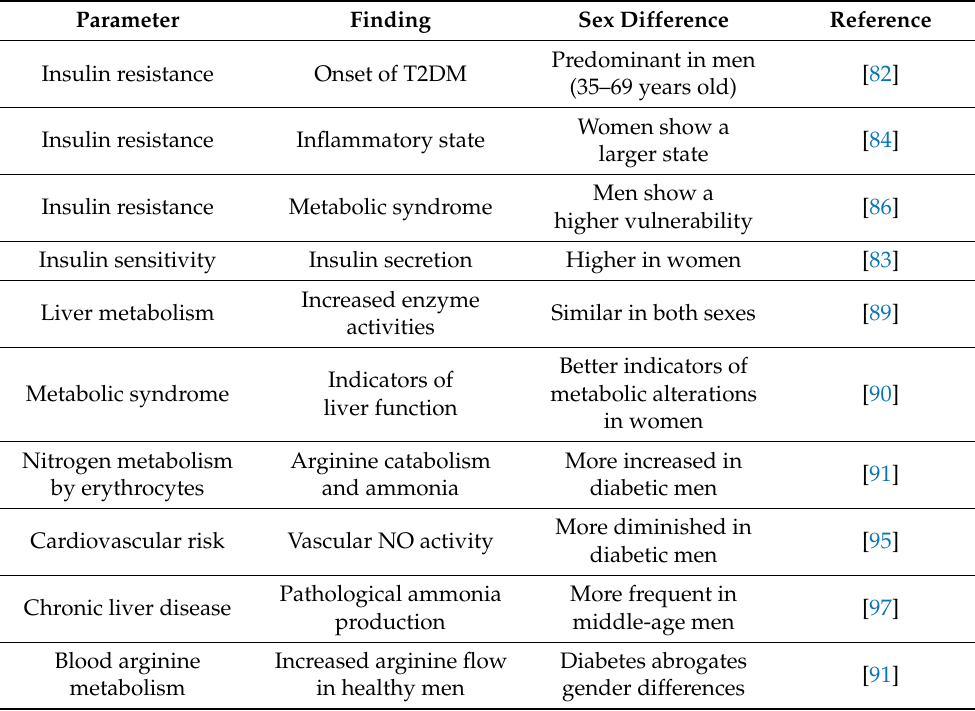
Table 1. Some gender differences in metabolic regulation, parameters of inflammation and oxidative stress, as well as diabetes